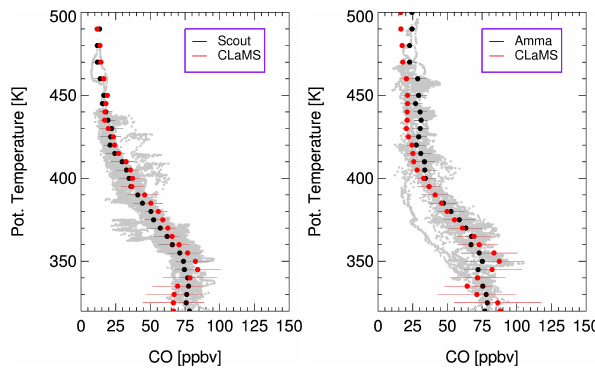
Figure 5. Climatological comparison of vertical CO profiles mea- sured by the COLD instrument aboard the Geophysica aircraft in the tropical tropopause region with CLaMS simulations. The cli- matology of CO measurements (grey dots) is based on the COLD measurements in the campaigns SCOUT-O3 (November 2005, left panel, Brunner et al., 2009) and AMMA (Summer 2006, right panel, Cairo et al., 2010). The vertical profile of the mean of all CO measurements in the respective campaigns is shown as black sym- bols with the horizontal bars denoting the standard deviation of the mean. The corresponding model values (derived by interpolating the model information on the location and time of the measurements) are shown in red.